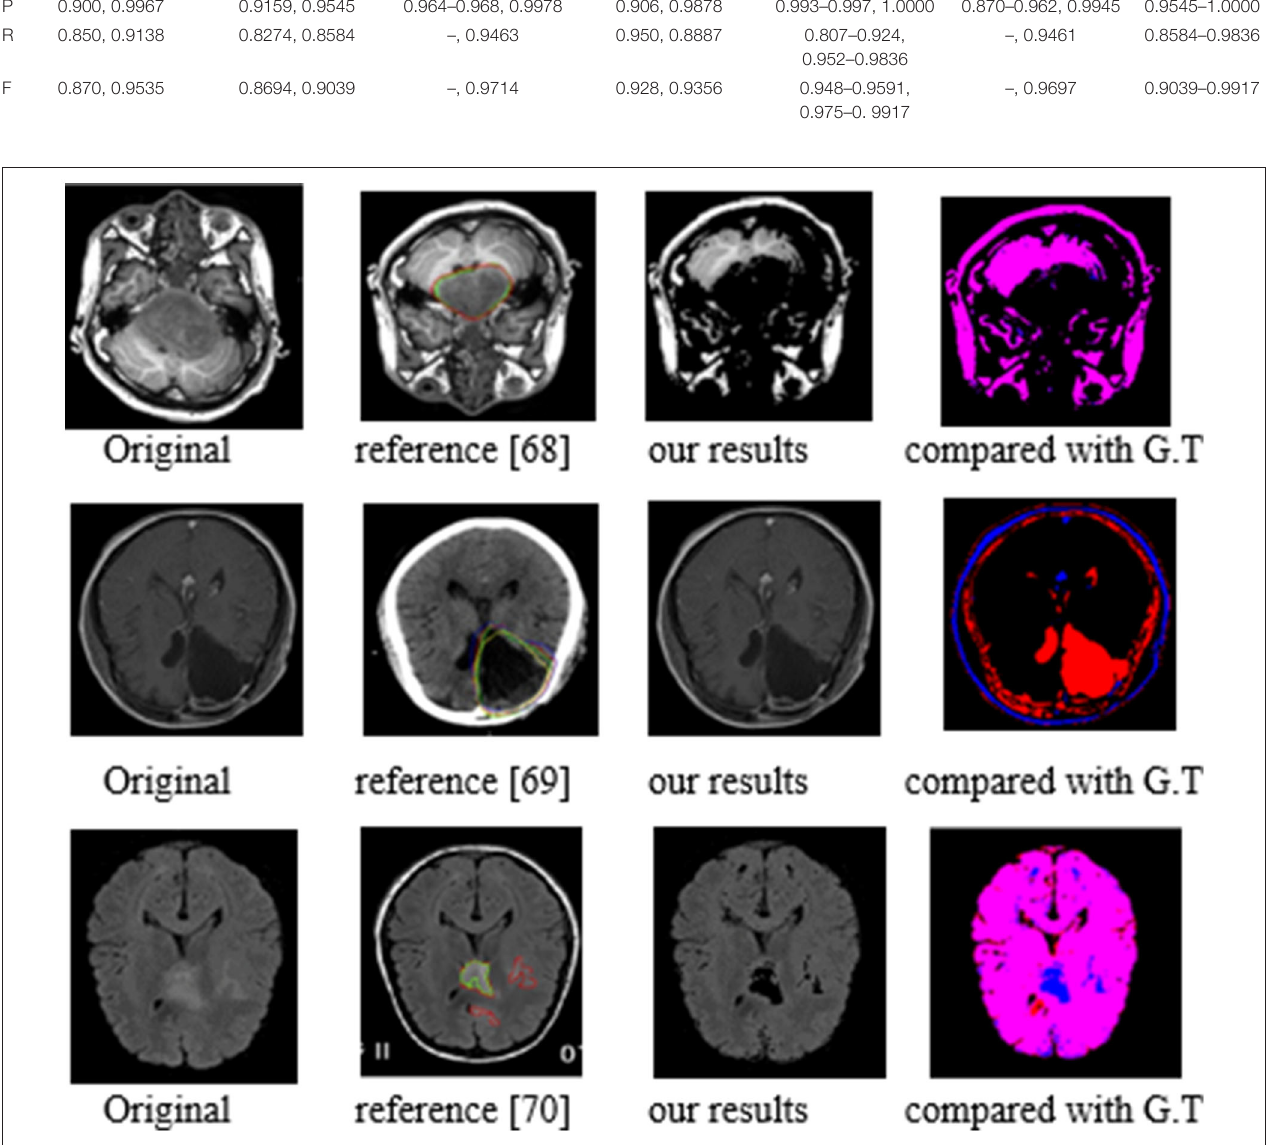
FIGURE 18 | The example of patient images segmentation results.